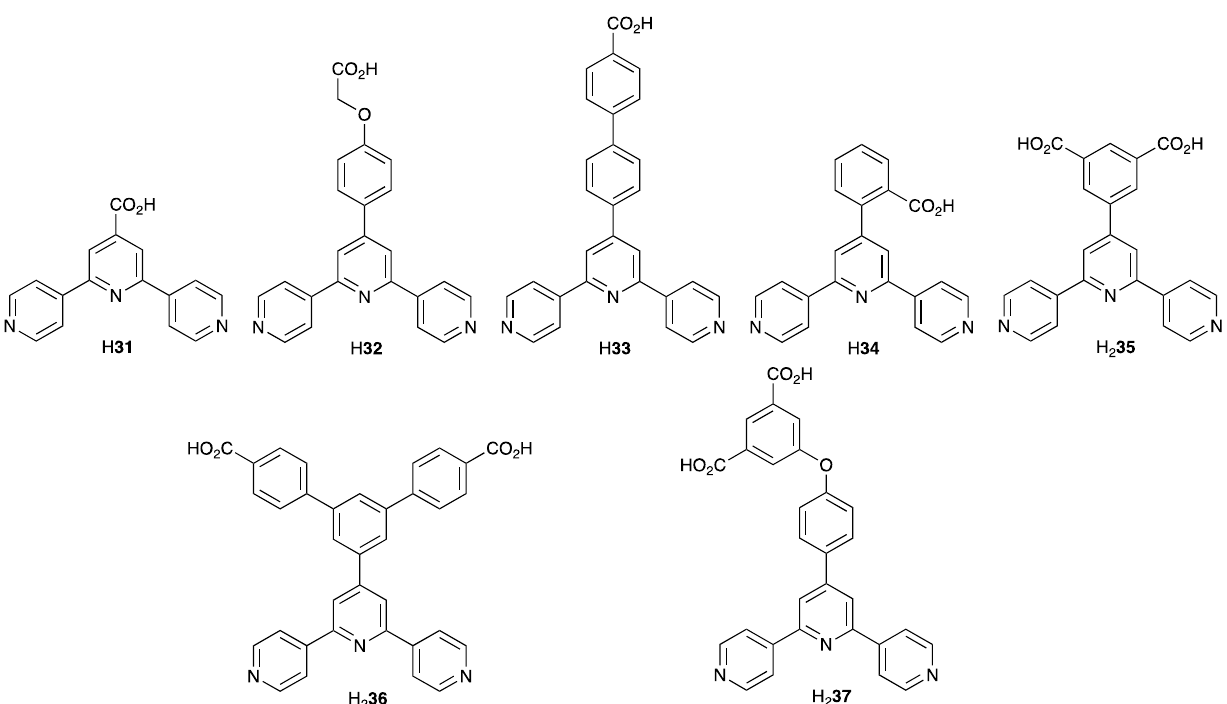
Scheme 10. Structures of 4,2’:6’,4” ‐ tpy ligands functionalized in the 4’ ‐ position with substituents containing carboxylic acid moeities. See Scheme 6 for the structure of H 17 .